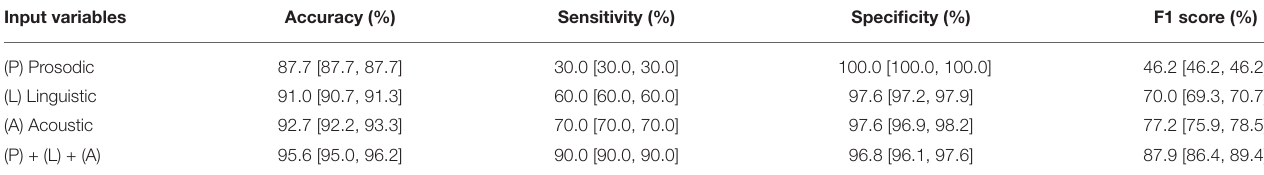
TABLE 3 | Classification model performance of speech features detecting individuals with high loneliness level resulting from 20 iterations of 10-fold cross